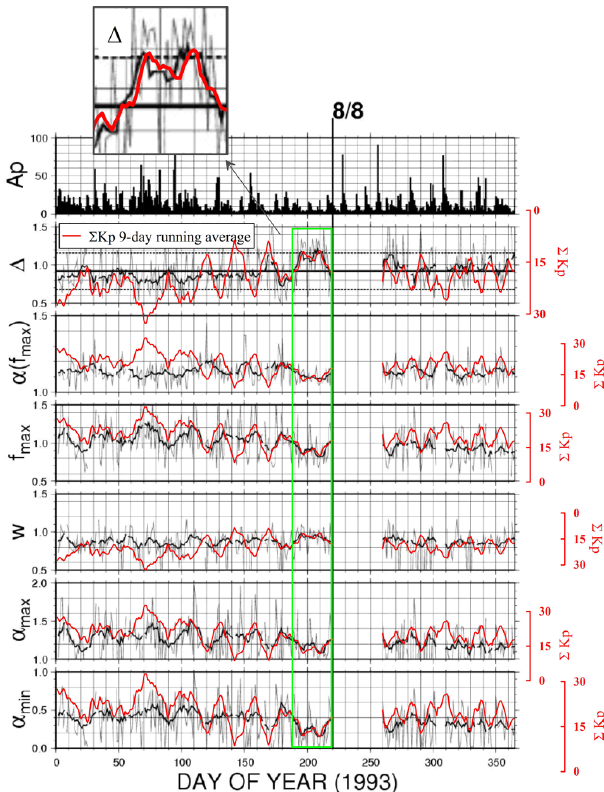
Fig. 1. A reproduction of Fig. 4 by Ida et al. (2005). From the top: geomagnetic Ap index and multi-fractal parameters 1 , α(f max ) , f max , w , α max , and α min daily values (thin black lines) and 9-day running average (thick black lines) time series. The area bounded by the green line highlights the period of the occurrence of the pre- sumed precursors of Guam earthquake. 6K p 9-day running average (red line) is superimposed onto each multi-fractal parameters panel. An enlarged view of 1 before the Guam earthquake is reported at the top of the figure. See text for details.